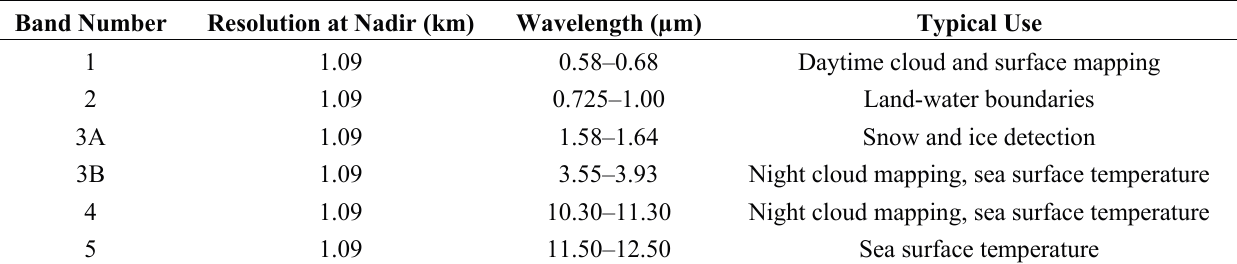
Table 1. AVHRR/3 band characteristics